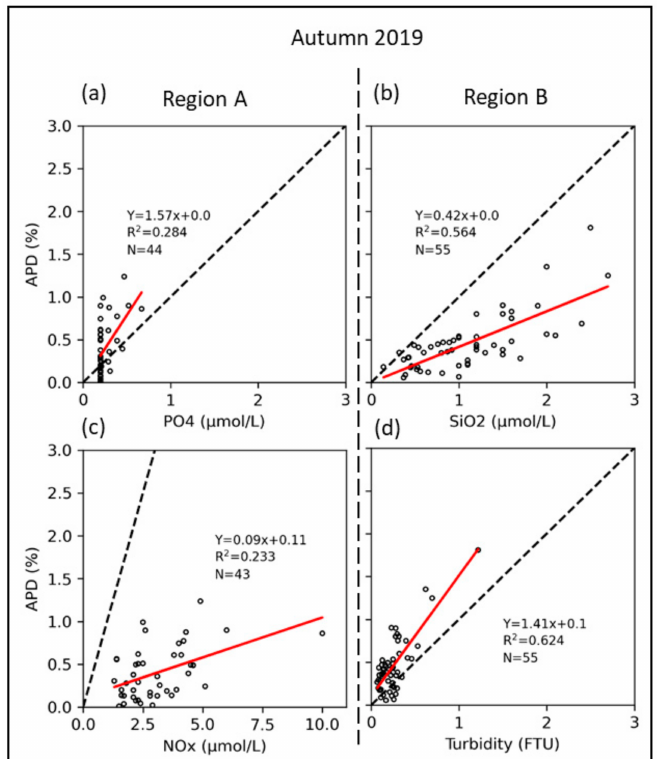
Figure 10. Linear relations between APD (%) and: ( a ) PO 4 , region A; ( b ) SiO 2 , region B; ( c ) NO x , region A; ( d ) turbidity, region B. These relations were the strongest linear relations found between APD and the studied environmental variables (data from Autumn